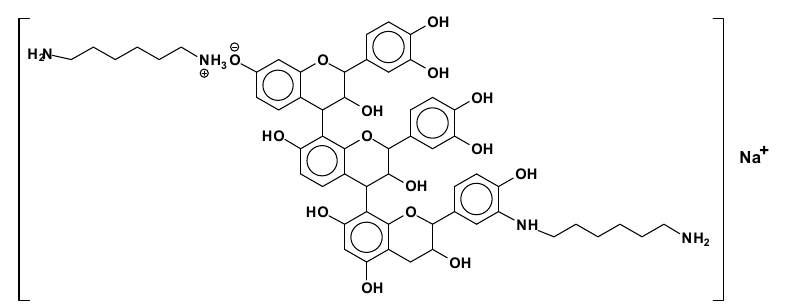
Figure 12. Example of a flavonoid trimer structure with amine reacted with mixed covalent bonds and ionic salt bonds at 1070 Da.